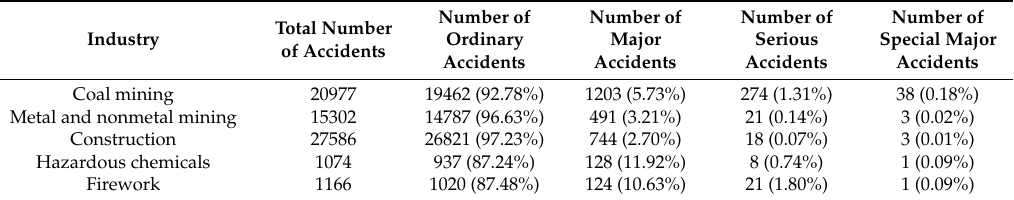
Table 2. Numbers of four scales of accidents in five high-danger industries in China